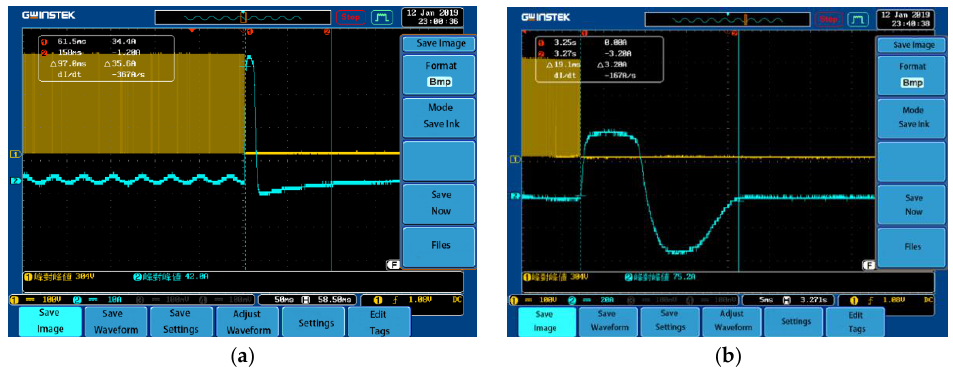
Figure 14. PMSM working under short-circuit braking mode. ( a ) 450 rpm; ( b ) 950 rpm.